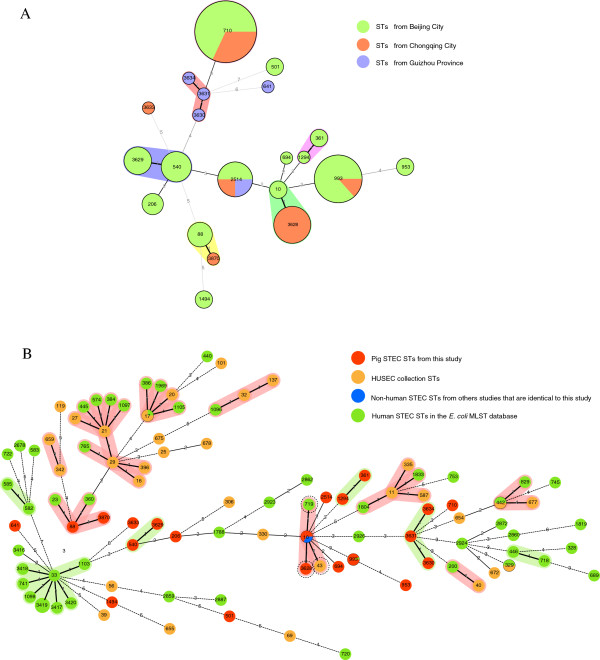
Genetic relationships of STEC isolates based on MLST. A) Genetic relationships of STEC sequence types (STs) from this study. Each circle represents a given ST with size proportional to the number of isolates. The colors for the slices of the pie represent places of isolates: Beijing city in green, Chongqing city in red and Guizhou province in purple. The numbers on connecting lines show the number of allelic difference between two STs. The number in a circle is the ST number. B) Minimal spanning tree of STs from this study, STs from the HUSEC collection and other human STEC STs. Ninety-three pig STEC isolates (in red) were compared to STs of HUSEC collection (in orange), human STEC STs (in green) and STs from other source that are identical to STs in our study (in blue) in E. coli MLST database. Each circle represents a given ST with the pie proportional to number of isolates in a given ST from different sources. The numbers on connecting lines show the number of allelic difference between two STs. The number in a circle is the ST number.